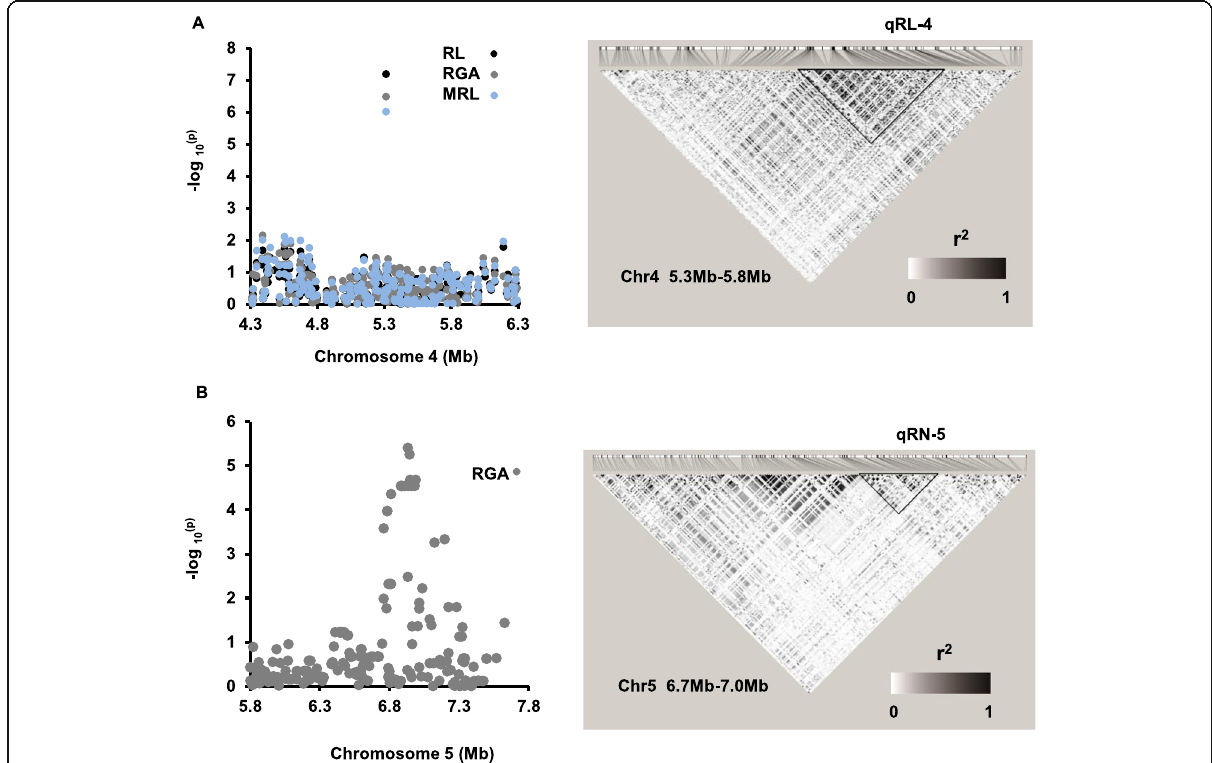
Fig. 5 Estimation of the candidate regions by local linkage disequilibrium analysis on chromosome 4 and chromosome 5. a Local manhattan plots (left) of GWAS for MRL, RL, and RGA for the Pop2 association panel and linkage disequilibrium heatmap (right) surrounding the peak on Chromosome 4. b Local manhattan plots (left) of GWAS for RGA for the Pop2 association panel and linkage disequilibrium heatmap (right) surrounding the peak on Chromosome